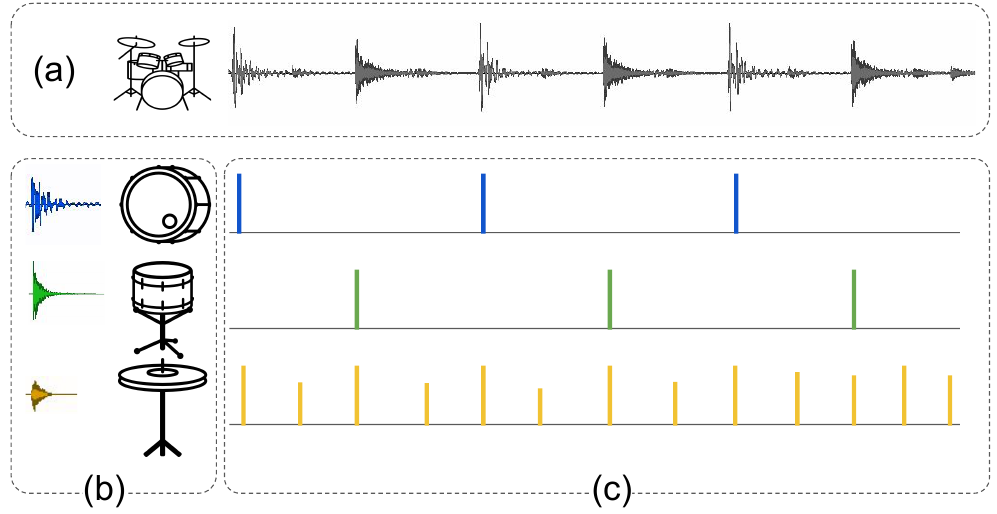
Figure 1. Conceptual illustration of the drum mixture decomposition problem: a percussive mixture ( a ) is decomposed into prototypical samples of the used instruments ( b ) and the corresponding onsets ( c